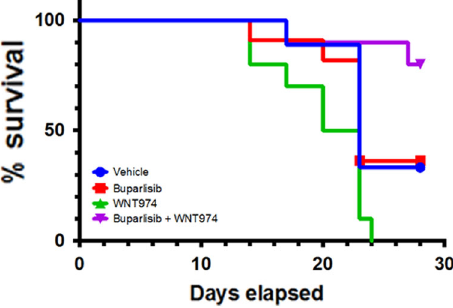
Fig. 5 NSG mice were implanted with a TNBC PDX and were treated in four groups ( n = 10 each): vehicle, buparlisib, WNT974, and the combination of buparlisib + WNT974. At the end of the experiment, 80% of mice treated with the combination survived to the end of the study. In comparison, only 40, 30, and 0% of mice survived treated with buparlisib, vehicle, and WNT974,